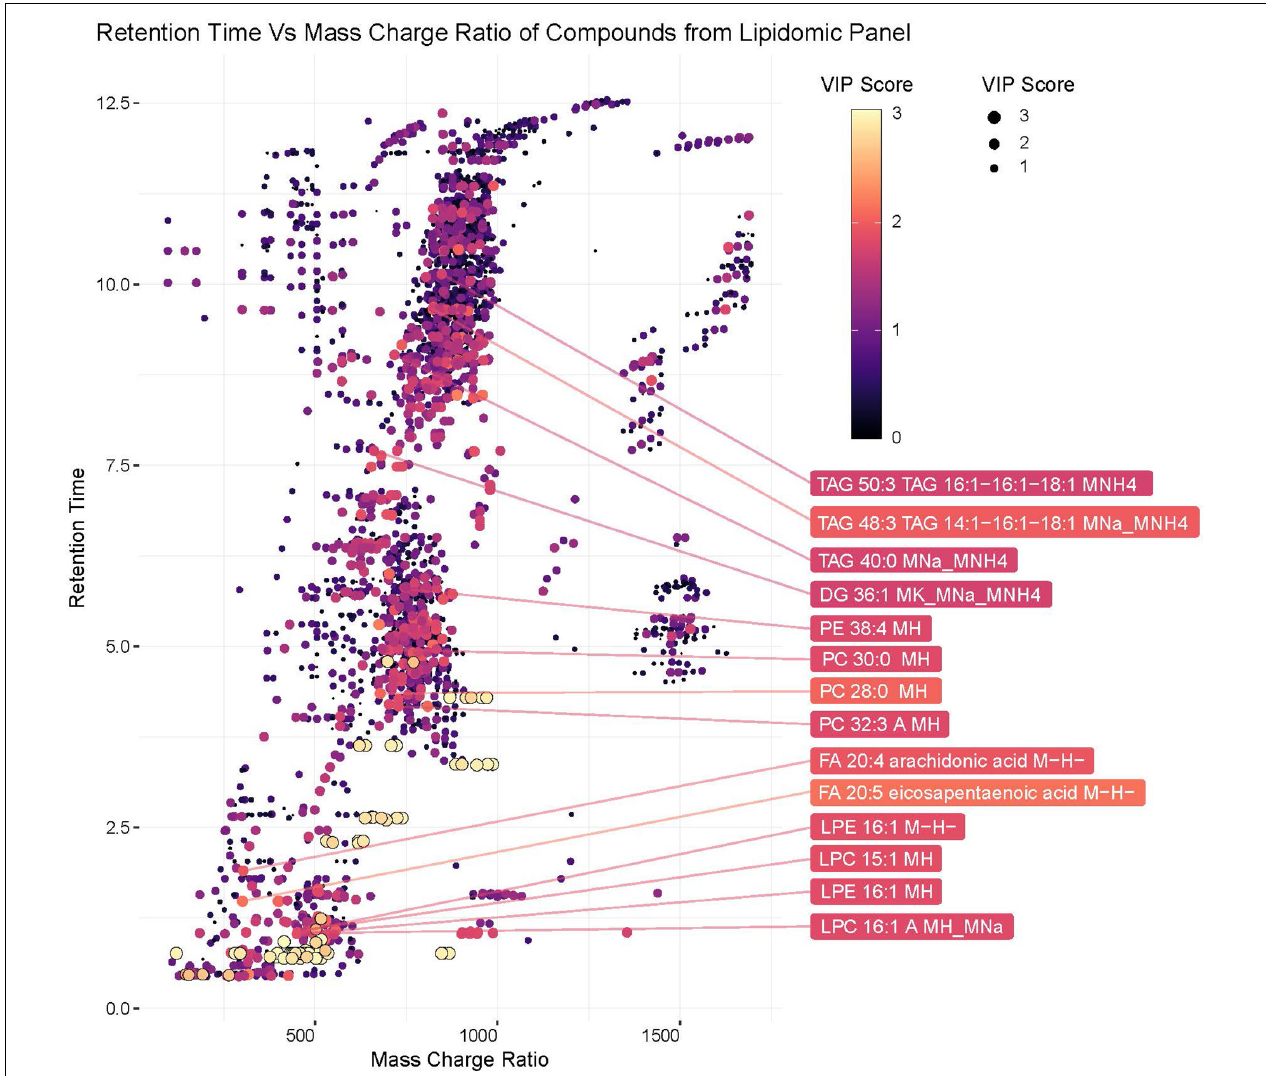
FIGURE 5 | Plot of hydrophobic compounds identified by LC/MS based on mass/charge ratio and retention times. To visualize compounds with common physical features associated with significant compounds, mass/charge ratio was compared against the Gas Chromatography Column retention time. The Identified lipids within the top 200 VIP scores were annotated. The VIP scores for each compound are represented by the color and size of each